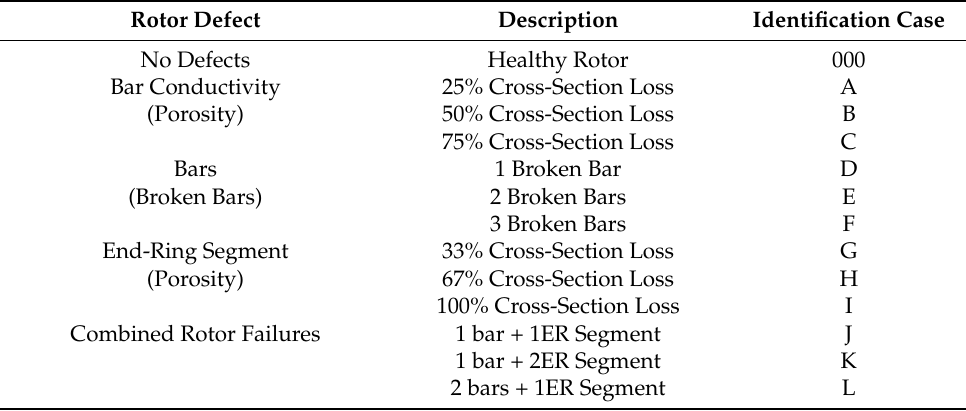
Table 2. Subdivision of rotor failures simulated on testing